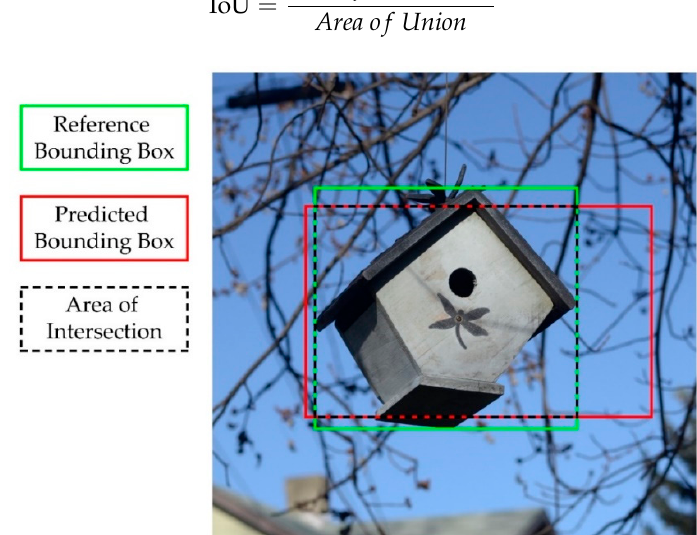
Figure 2. Conceptualization of the intersection-over-union (IoU) metric, which is commonly used to assess feature recognition results using bounding boxes.